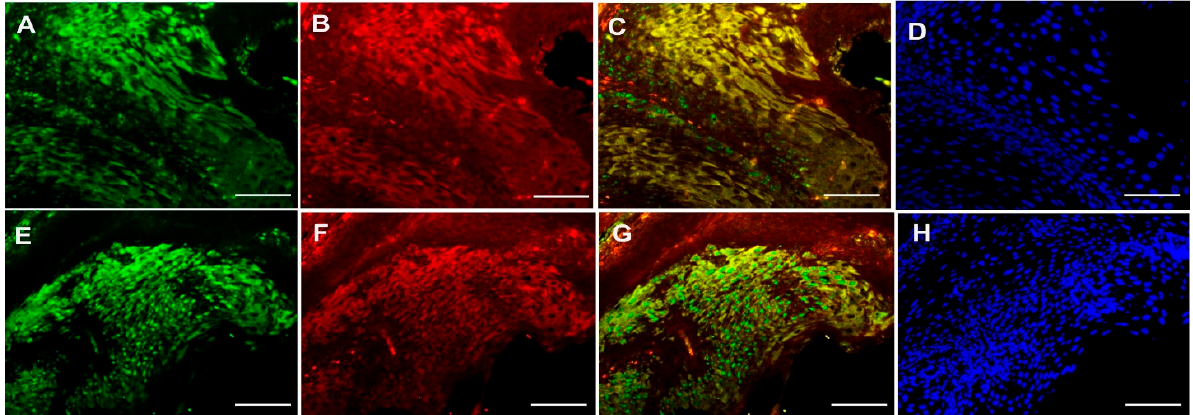
Figure 2. Double Immunofluorescence analysis of CXCR-4 with PKC- δ and CD133 in human oral carcinoma tissues. Upper panel: CXCR4 ( A ), PKC- δ ( B ), CXCR-4 and PKC- δ co-localization ( C ) and DAPI ( D ) staining in oral cancer tissue. Lower panel: CXCR4 ( E ), CD133 ( F ), CXCR-4 and CD133 co-localization ( G ) and DAPI ( H ) staining in oral cancer tissue (Scale bar—20 µm).